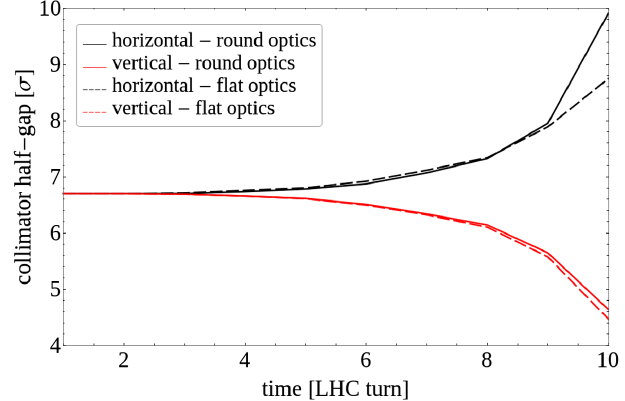
FIG. 11. The effective collimator gap settings of the dump absorber (TCDQ) and the horizontal tertiary collimators (TCTH) in IPs 1 and 5 following a CLIQ discharge in the Q2 magnet left of IP1, constituting the fastest case — round optics.